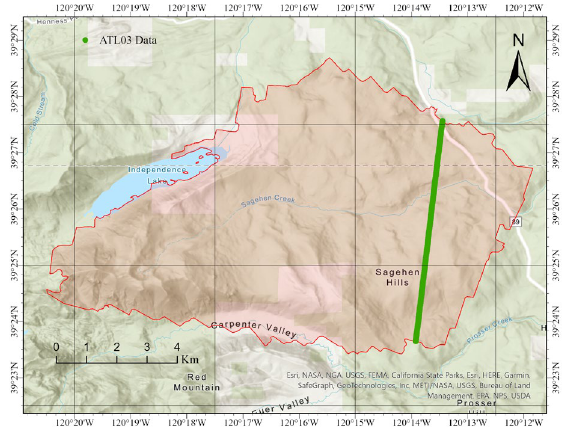
Figure 1 . Dataset profile.